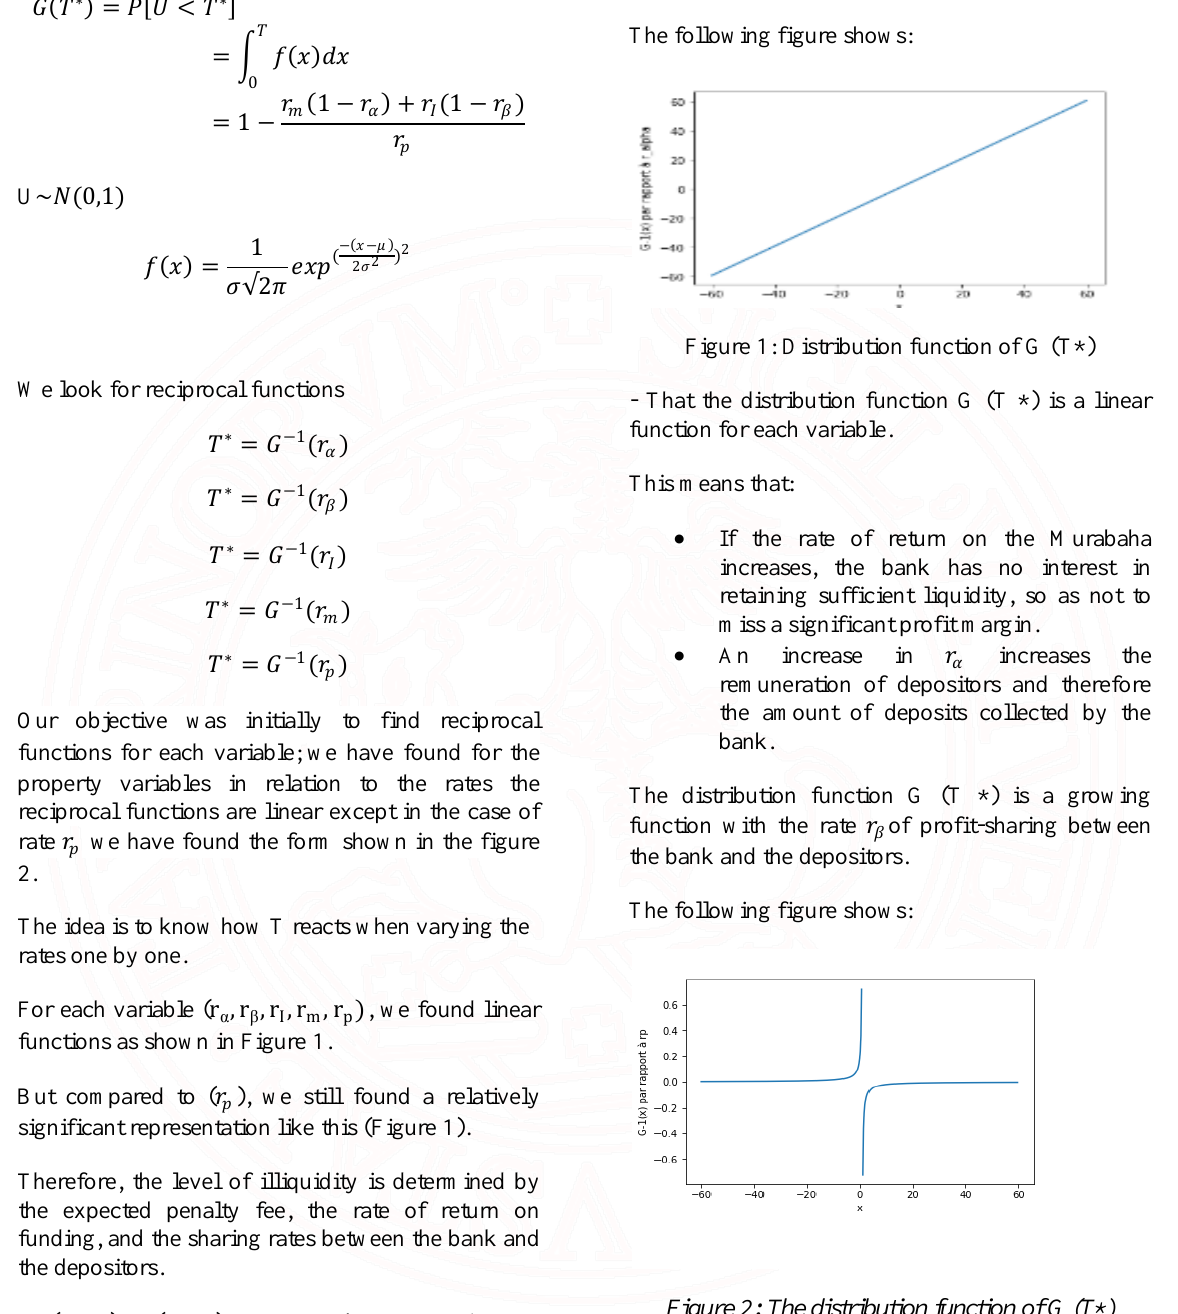
Figure 1: Distribution function of G (T*)